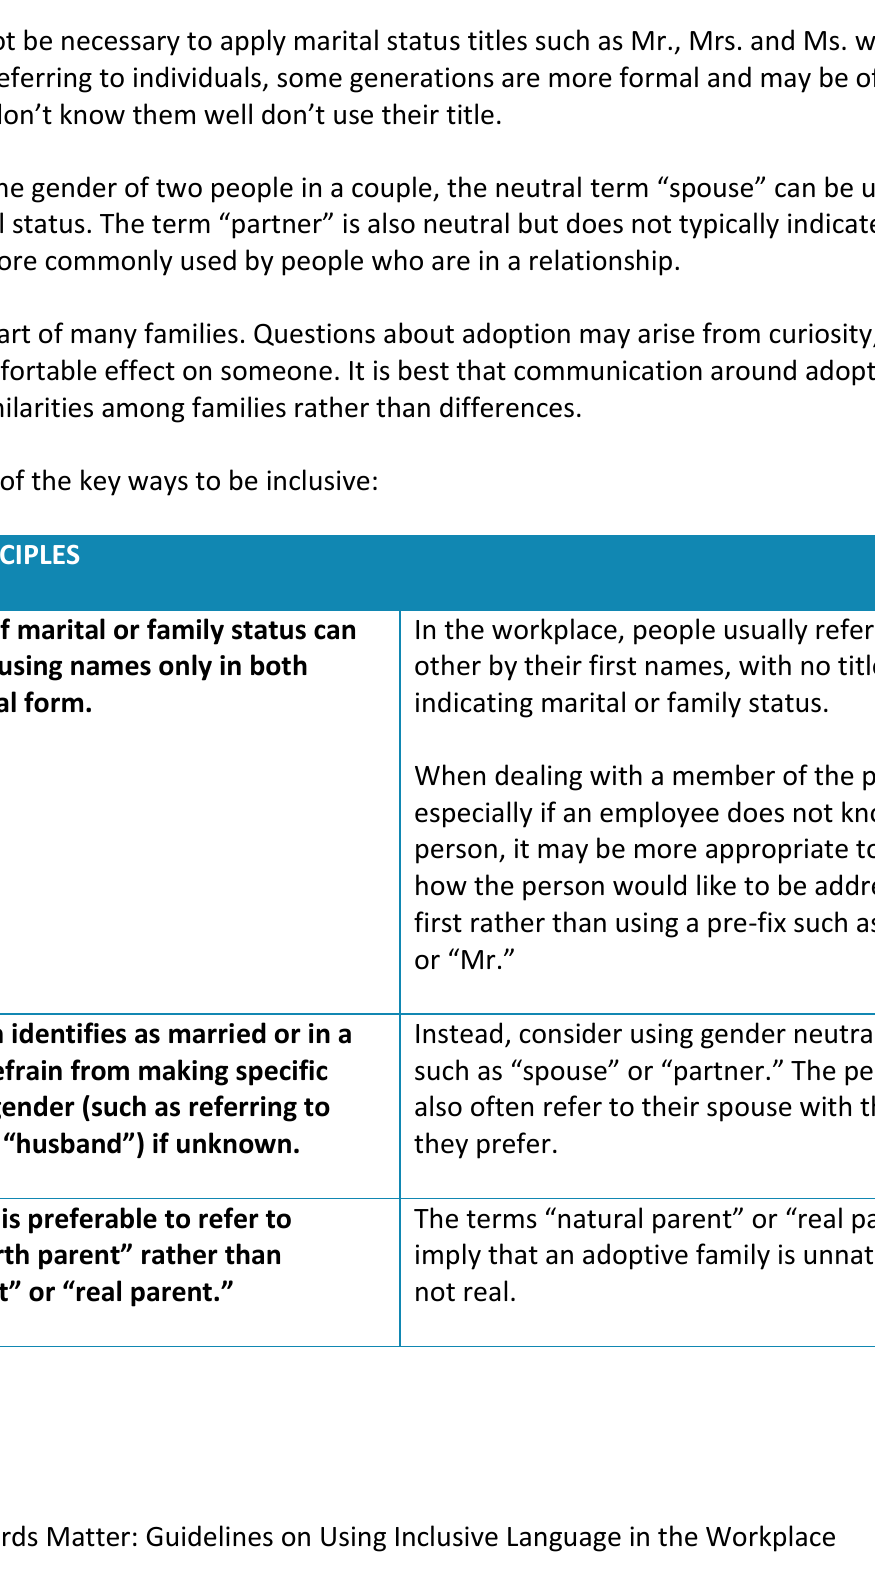
Page | 16 | Words Matter: Guidelines on Using Inclusive Language in the